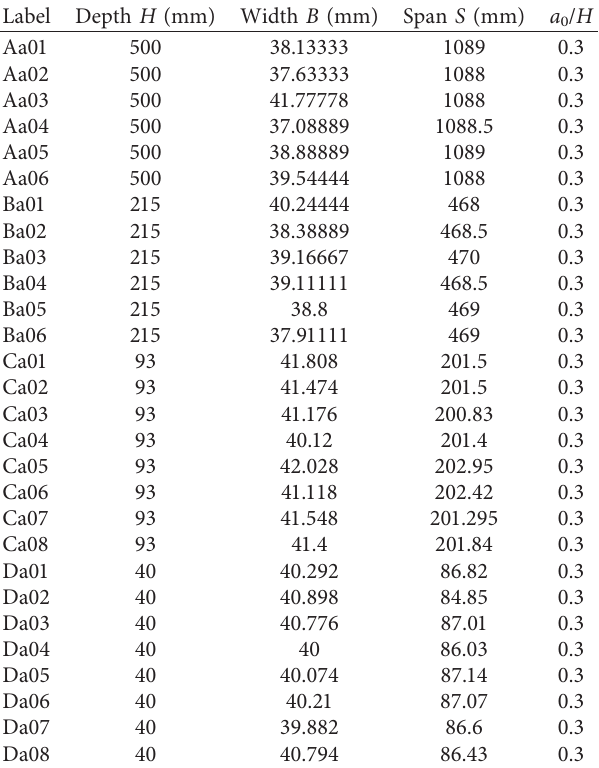
Table 5: Geometric parameters of specimens for three-point bending tests on notched beams [26].